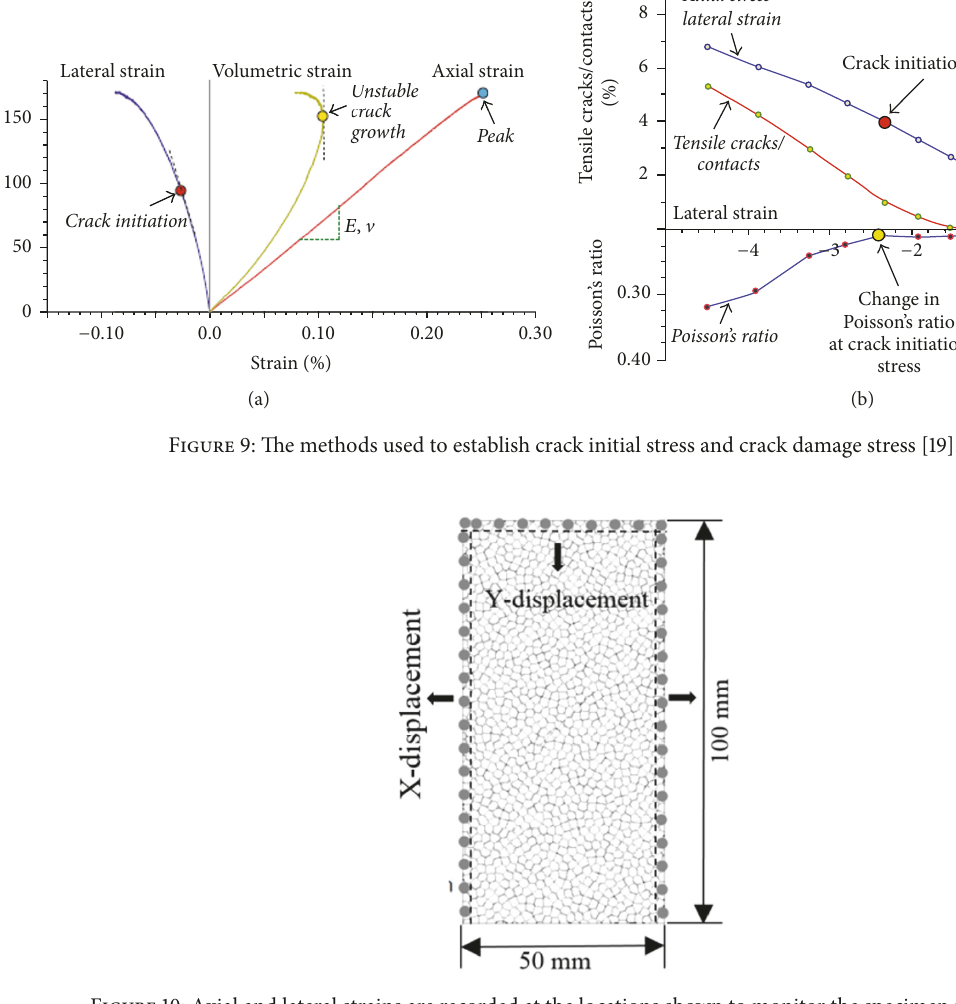
Figure 10: Axial and lateral strains are recorded at the locations shown to monitor the specimen